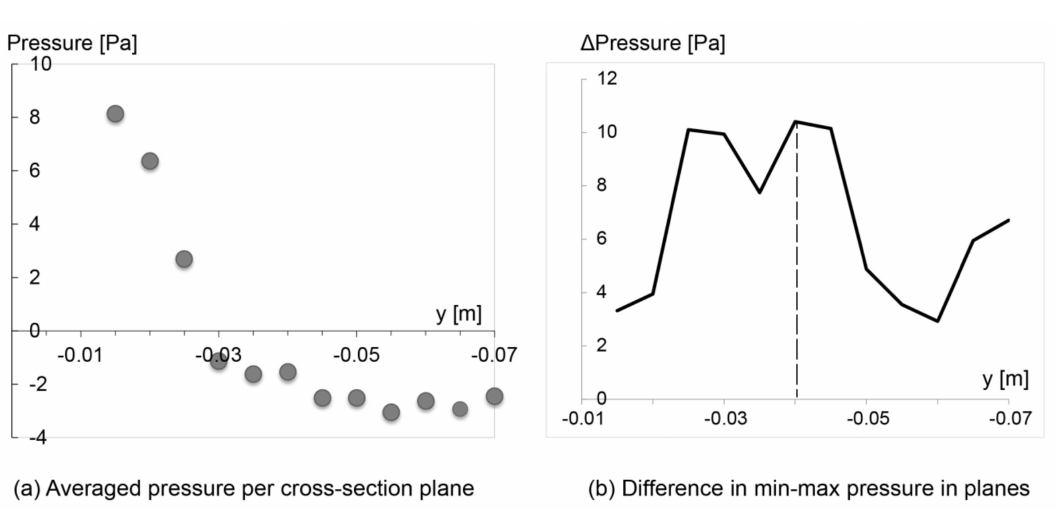
Figure 10. ( a ) Pressure drop of the main airflow; ( b ) Pressure di ff erence between the minimum and maximum pressure values within each